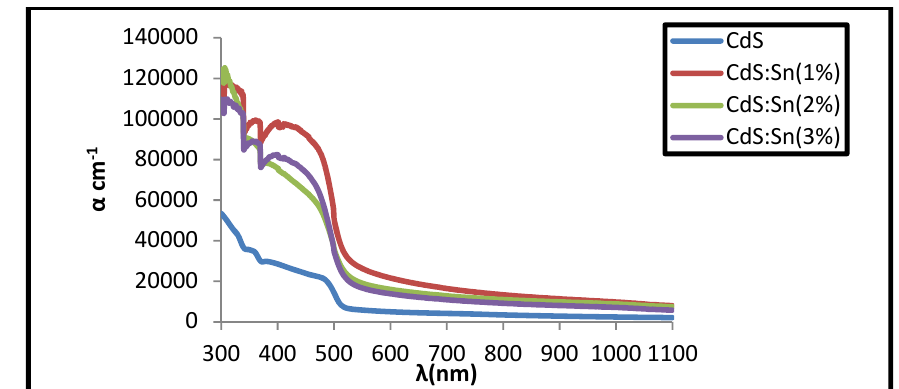
Fig. 4: Absorption coefficient of CdS and CdS:Sn thin film .